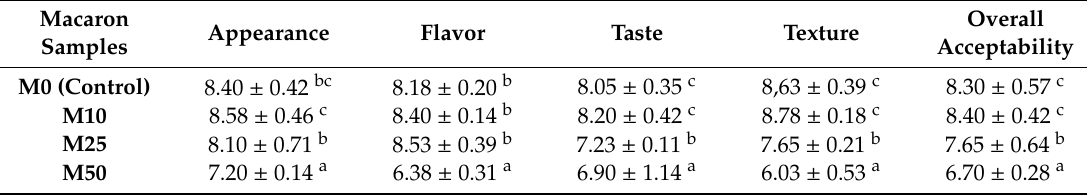
Table 7. Sensory evaluation of modified macaron